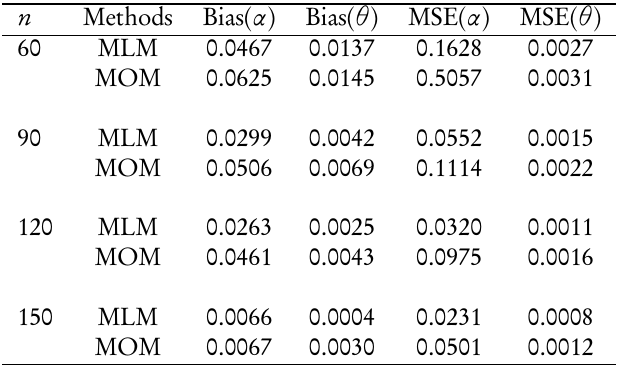
Monte Carlo simulation results for α = 0.15 , θ = 0.35 .